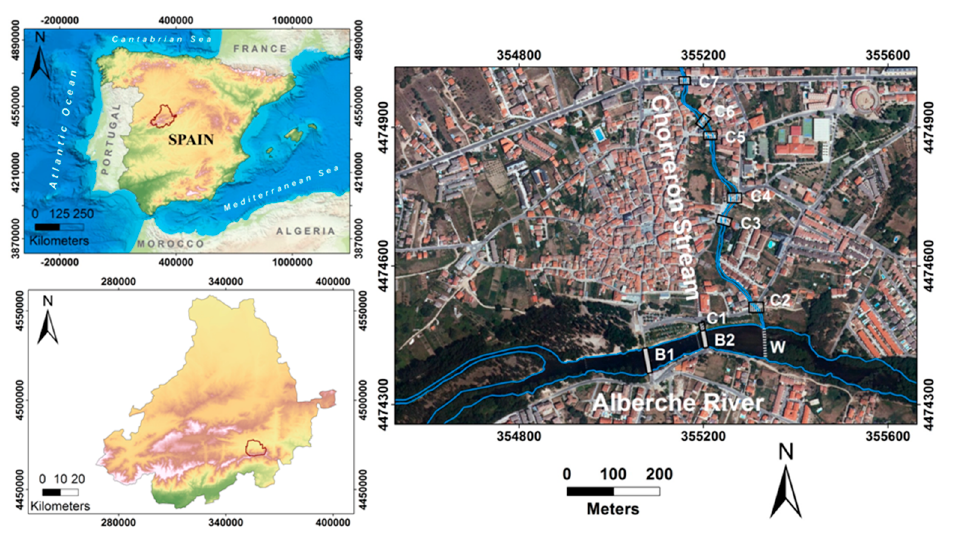
Figure 1. Location of the study area. Coordinate system: ETRS89, UTM Zone 30 N. There are several points of conflict in the reaches studied: ( i ) B1 and B2 correspond to bridges on the Alberche River; ( ii ) W is a weir also on the Alberche River; and ( iii ) C1 to C7 represent culverts on the Alberche River and the Chorreron Stream.